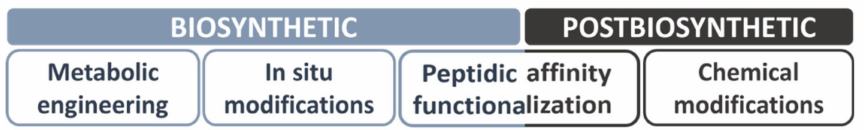
Figure 6. Flowchart of the different approaches used in the literature to modify bacterial